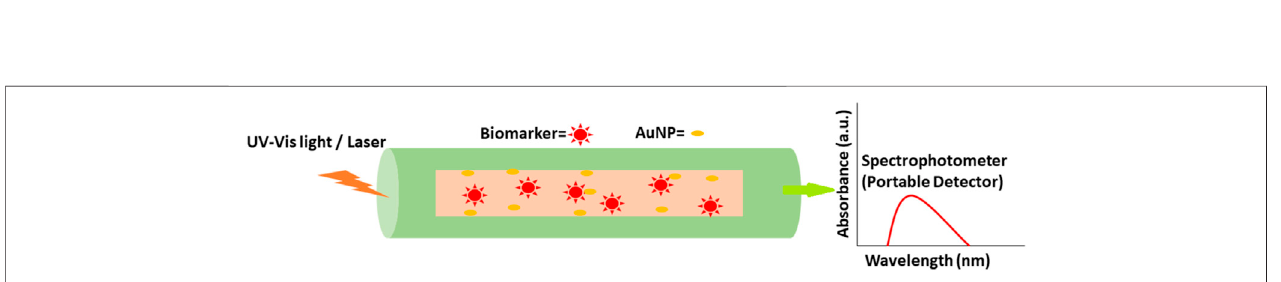
FIGURE 10 | AuNP fabricated portable optic fi ber biosensor in cancer biomarker detection.